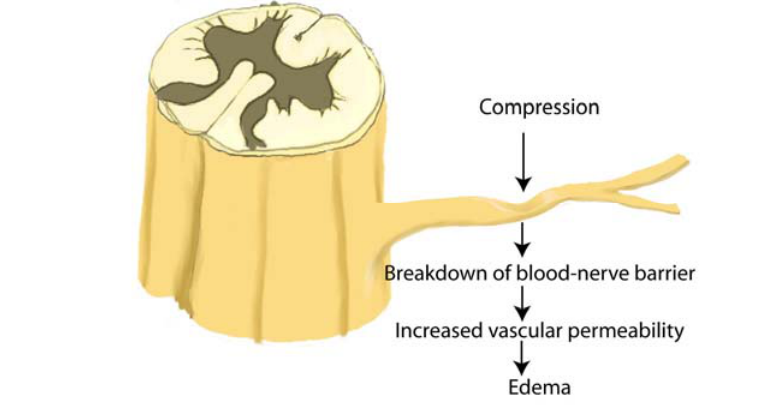
Figure 7. Nerve root compression produces increased vascular permeability at the site of compression, in the peripheral zone of a compressed anterior nerve root, and in the central zone of a compressed posterior nerve root. After nerve root compression, degeneration of the nerve is found in the area of increased vascular permeability. DR: dorsal root, DRG: dorsal root ganglion, VR: ventral root (adapted from Kobayashi et al.